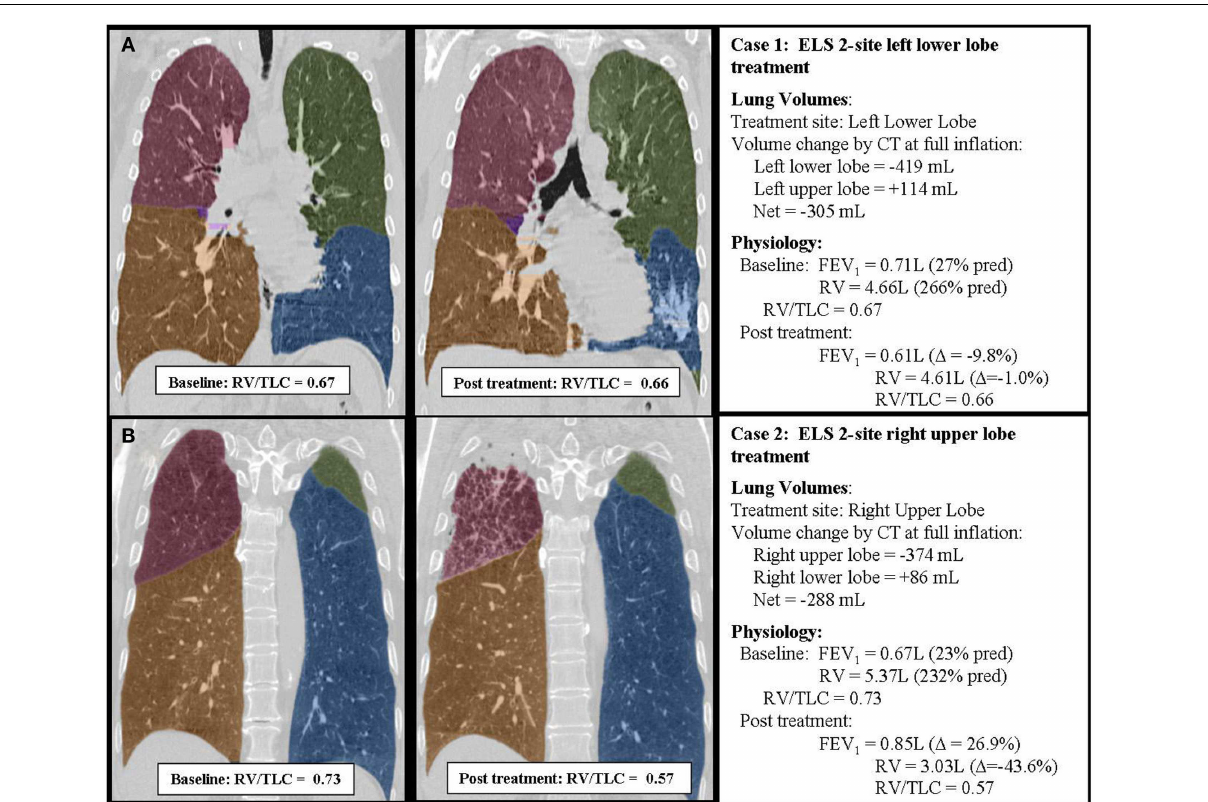
FIGURE 4 | Case summaries of two patients treated with ELS illustrating the differential effects of upper (B) and lower (A) lobe lung volume reduction. The two cases were closely matched with respect to baseline patient characteristics, baseline physiology, and extent of lobar volume reduction measured by CT imaging. However, responses to treatment were quite different. Upper lobe treatment (B) was associated with a substantial improvement in lung function. Lower lobe treatment (A) had minimal beneficial effects on lung function. In each example, the